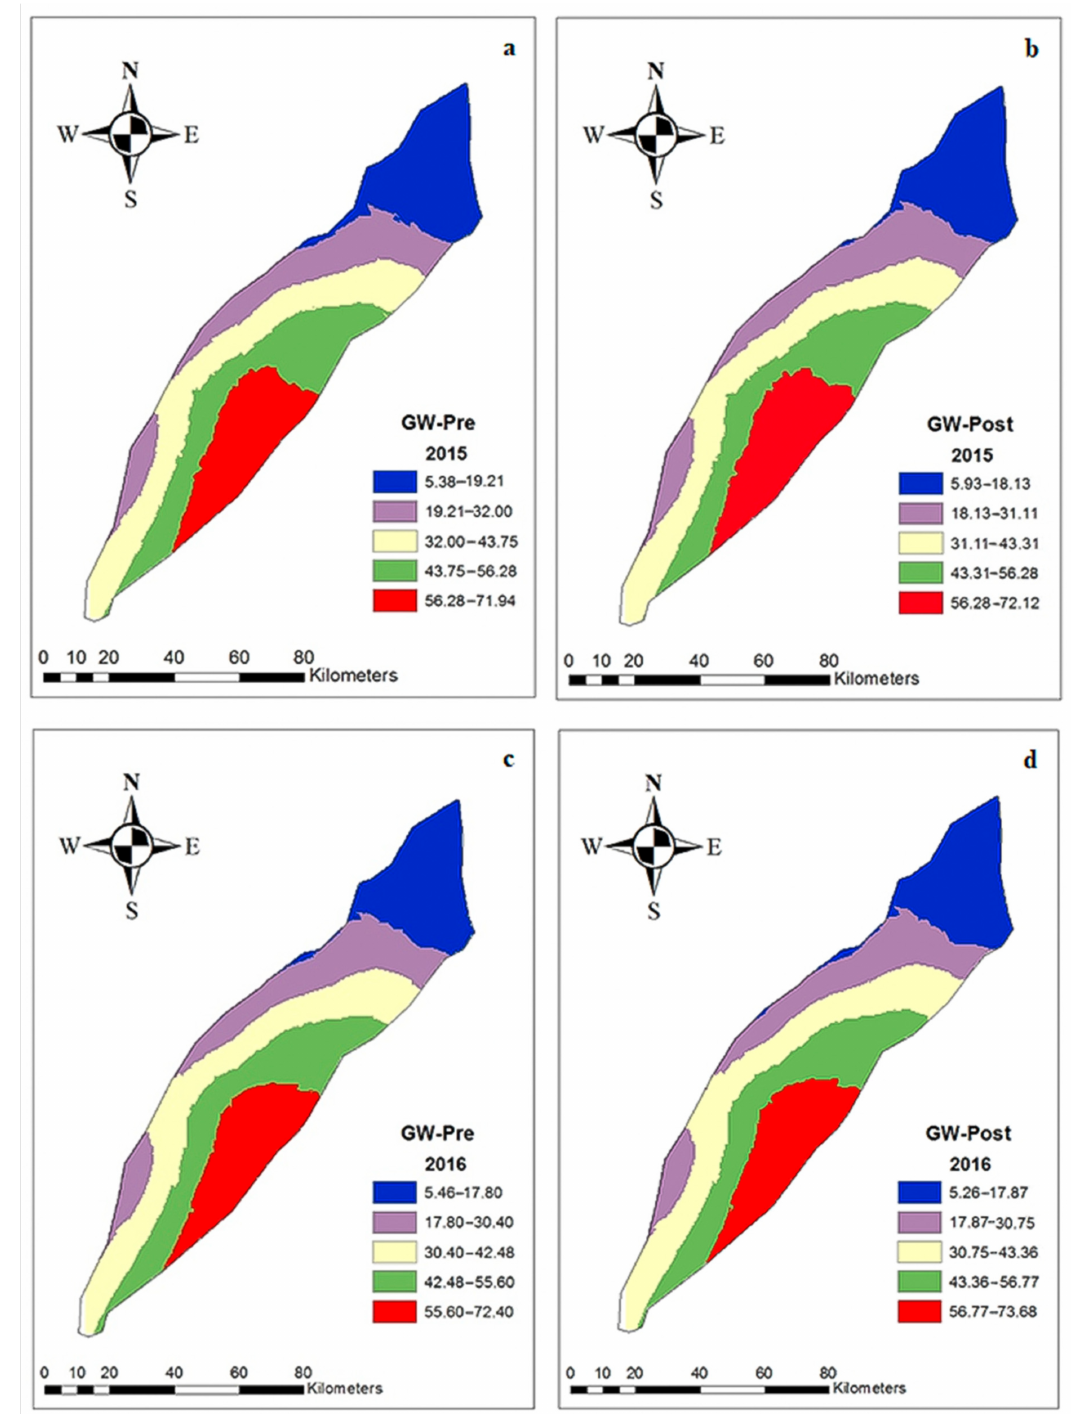
Figure 8. Spatial distribution of groundwater level (GWL) ( a , b ) in 2015 and ( c , d ) in 2016 for pre monsoon and post